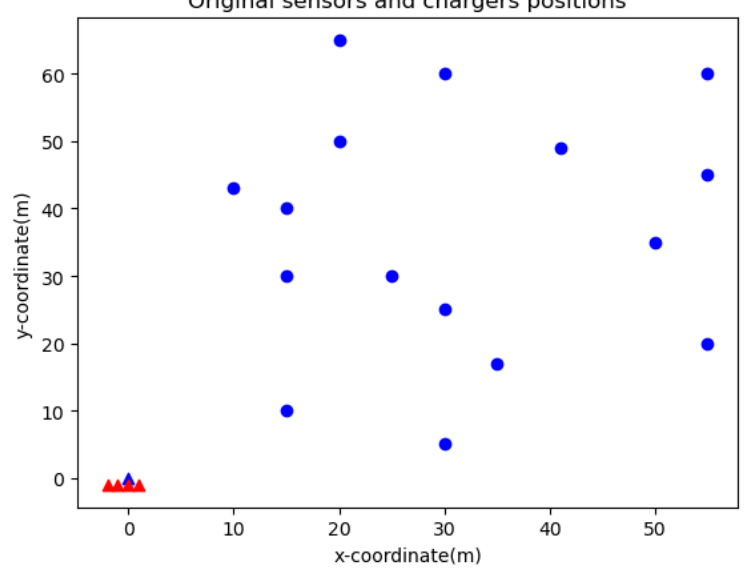
Figure 13. Schematic of